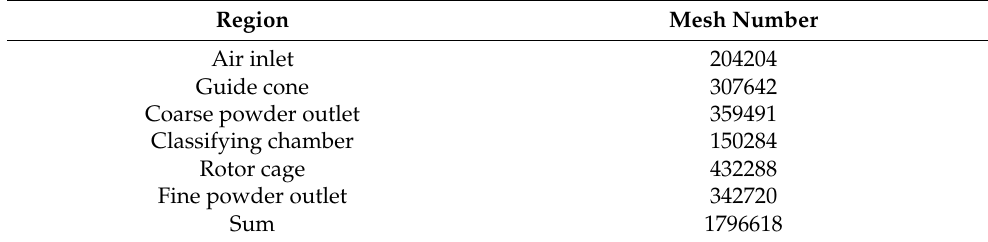
Table 2. Number of meshes in each